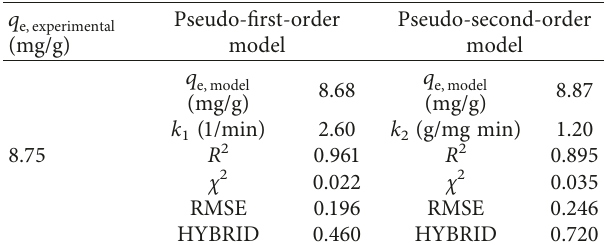
Figure 6: (a) Influence of the contact time and (b) kinetic modeling 7.5; of the NH 4+ adsorption by Al-waste-NaP1. Conditions: pH (cid:29) adsorbent dose 5g/L; Co 50mg/L; T 28 2 ° (cid:29) (cid:29) (cid:29) ± Table 1: Kinetic model parameters and error function values obtained for the NH 4+ adsorption onto Al-waste-NaP1. q e , experimental (mg/g)